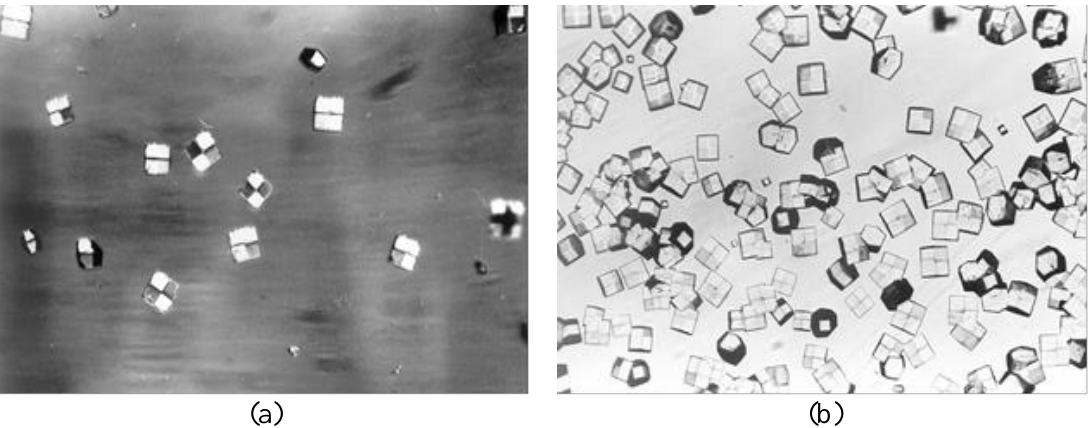
Figure 1. Preferred orientation of HEWL crystals on the cathode side. Imposed EF = 1500 V/cm, 20 mg/ml HEWL and 0.7 M NaCl. Crystal sizes: 35 μm–70 μm. ( a ) Dark field image, t = 0 °C. ( b ) Bright 20 mg/ml HEWL and 0.7 M NaCl. Crystal sizes: 35 µ m–70 µ m. ( a ) Dark field image, t = 0 ◦ C. ( b ) Bright field image, t = 5 °C [39] (with permission from [39]). field image, t = 5 ◦ C [39] (with permission from